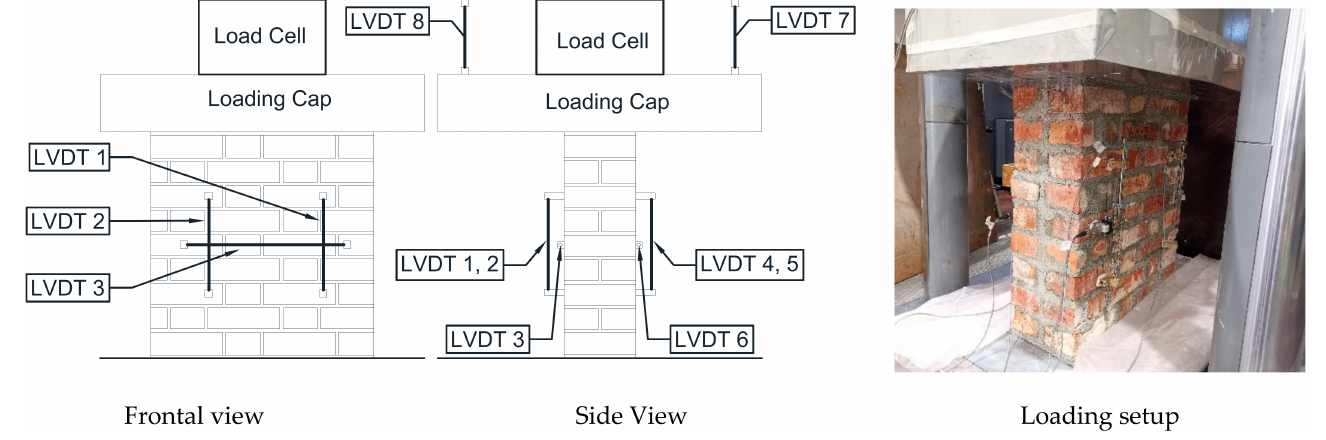
Figure 5. Location of the LVDTs on the masonry wallettes for Axial Compression